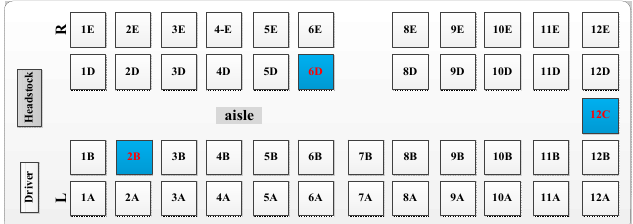
Figure 1. Bus seat arrangement.